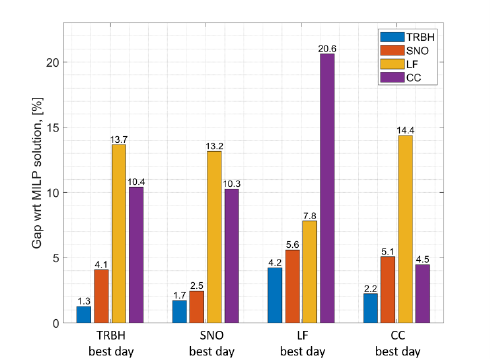
Figure 10. Distance from minimum operating cost of the scheduling approaches, in the days associ- ated with the best performance of each